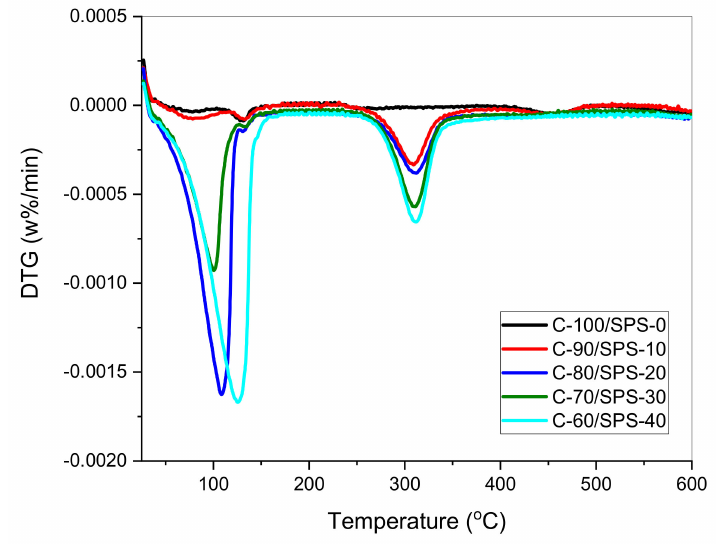
Figure 9. DTG curves for C/SPS